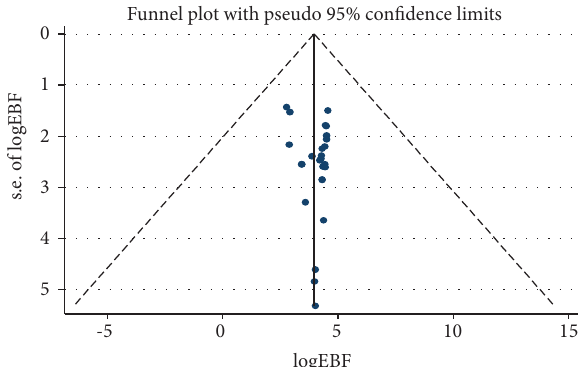
Figure 6: Funnel plot for publication bias for the prevalence of exclusive